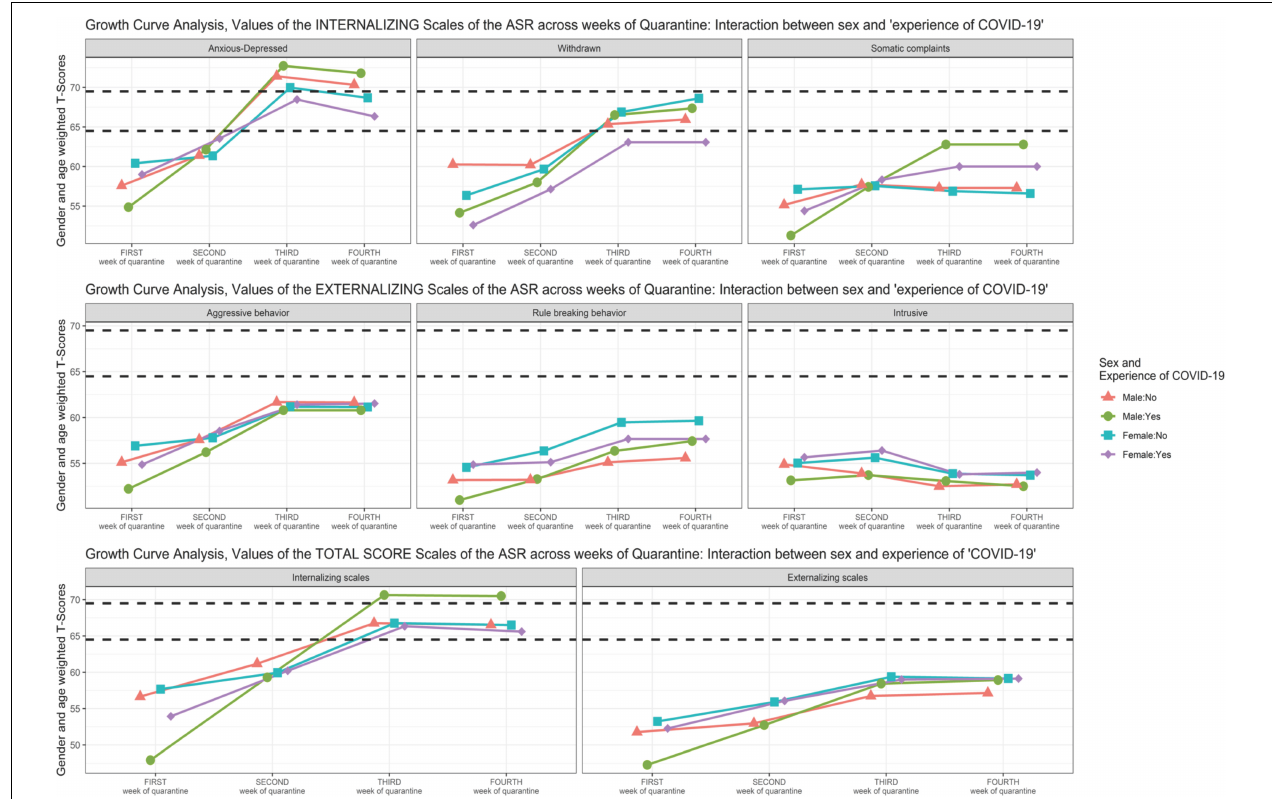
FIGURE 5 | Growth curve analysis (GCA): means of the Syndromic Scale across weeks of quarantine—interaction between “sex” and “experience of